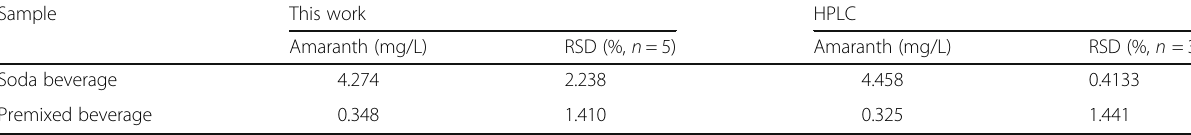
Table 2 Results of amaranth detection by proposed method and HPLC Sample